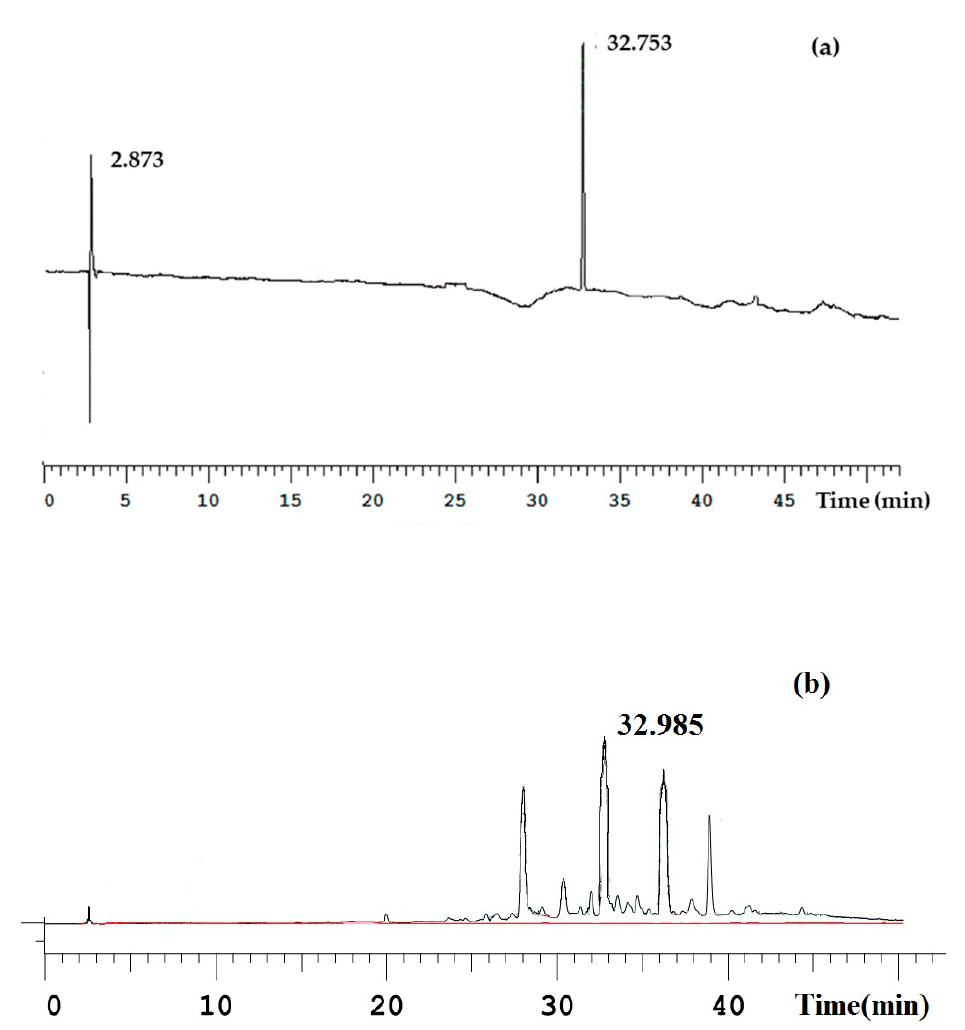
Figure 4. High performance liquid chromatography of: ECH standard ( a ); and sample ( b ). Sample: Fermentation products. The analytical conditions: chromatographic column: ZORBAX Eclipse XDB C18 column (250 × 4.6 mm, 5 µ m); mobile phase: acetonitrile (A) − 0.1% formic acid solution (B); elution condition: 0–10 min, 7–12% A; 10–35 min, 12–75% A; 35–50 min, 100% A; column temperature: 25 °C; detect wave length: 280 nm; and flow: 1